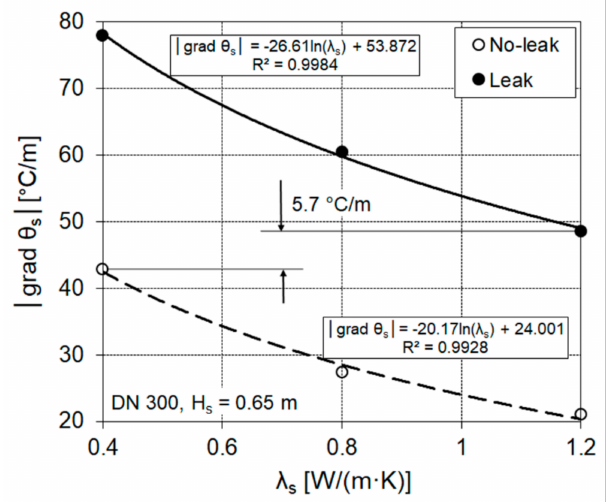
Figure 5. Comparison of no-leak and leak soil temperature gradients as a function of the soil thermal